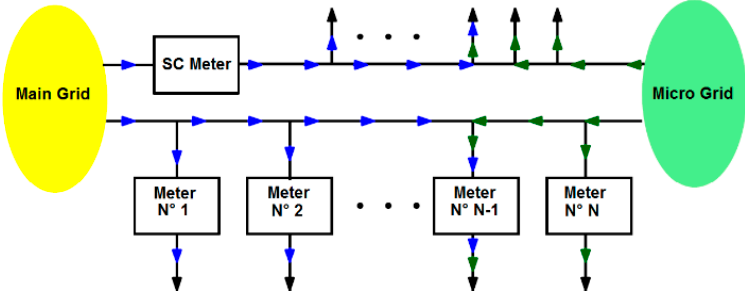
Figure 5. Energy flux and metering for separate customers.